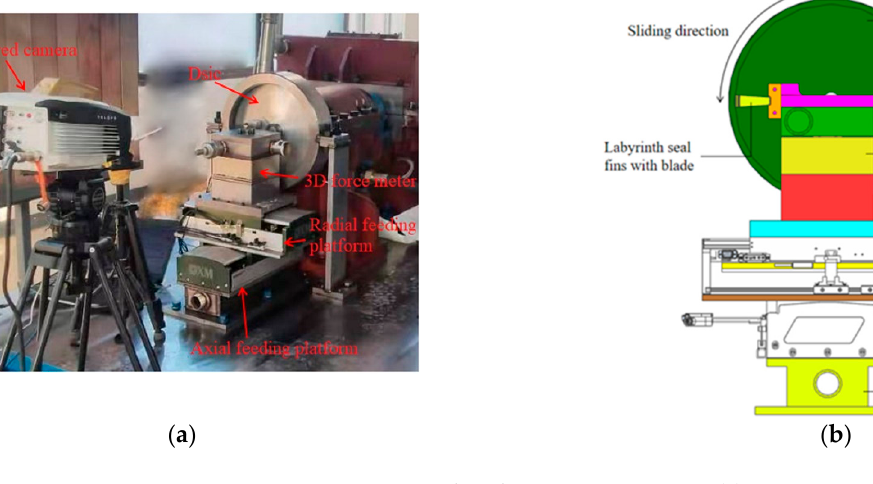
Figure 4. Incursion control and test measurement. ( a ) Measurement of temperature and force. ( b ) Schematic diagram of incursion control.